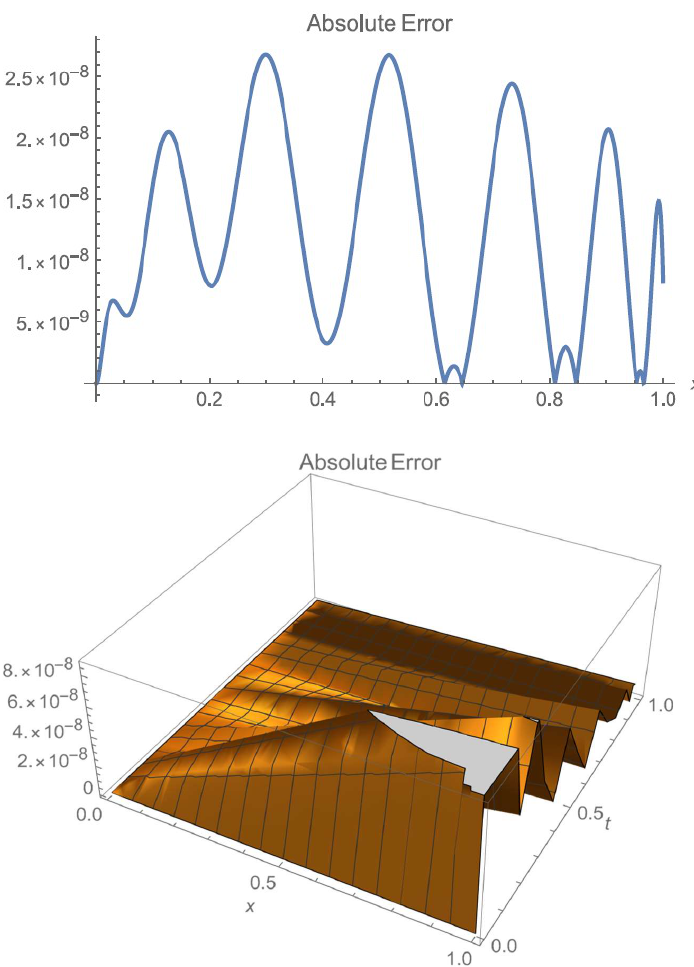
Figure 4. A plot of the absolute error between the exact and estimated solutions is depicted for t = x , on the left-hand side. The graph shows that the error is of the order of 10 −8 in one dimension. A 3D graph of the absolute error for exact and estimated solutions is also given on the right-hand sde which shows the accuracy of the numerical results of the order of 10 −8 over the intervals t ∈ [0,1] and x ∈ [0,1]. To achieve this level of accuracy in the solution, a total of 28 B-polys basis set was involved which is a product of 2 B-polys in variable x and 14 B-polys in variable t.